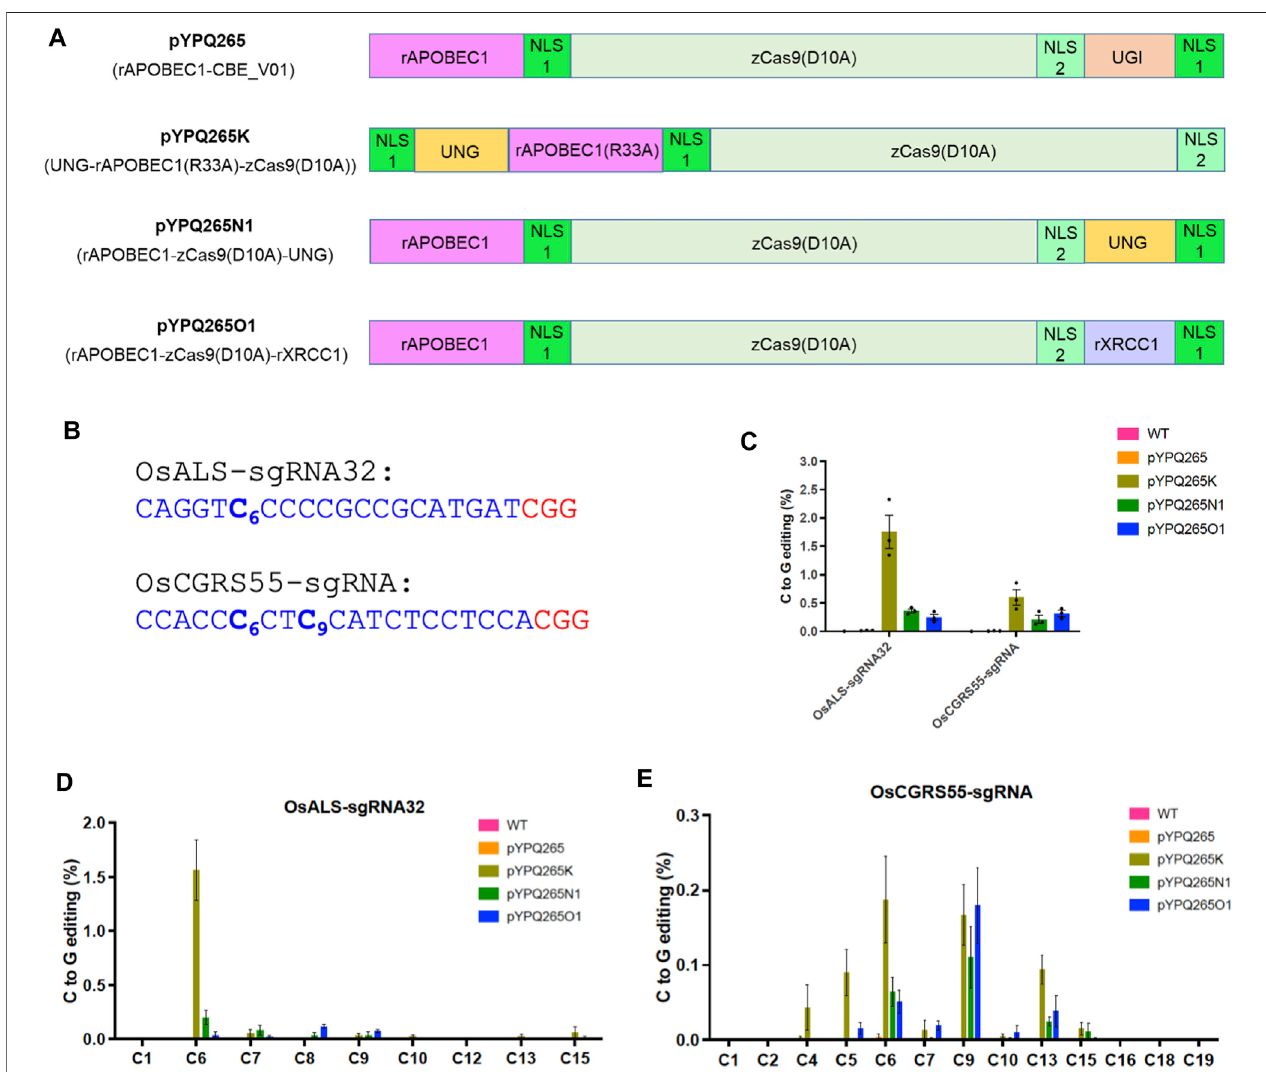
FIGURE1| AssessmentofBE3andthreeCGBEsinriceprotoplasts. (A) DiagramofBE3andthreeCGBEs.Noteeachnuclearlocalizationsingle(NLS)isindicated by a green box. NLS 1 is a monopartite SV40 nuclear localization signal and NLS 2 is a bipartite nuclear localization signal of nucleoplasmin. Both NLS1 and NLS2 are recognized by importin α . (B) The target sites in the rice genome. The protospacer sequence is highlighted in blue and the PAM is highlighted in red. (C) NGS quanti fi cation of C-to-G editing by four base editors in rice protoplasts. For the wild type (WT) samples, sterile deionized water was used in protoplast transformation. (D) NGS analysis of C-to-G editing windows by different base editors at the OsALS-sgRNA32 site. (E) NGS analysis of the C-to-G editing windows by different base editors at the OsCGRS55-sgRNA site. The error bars represent standard errors of three biological replicates.